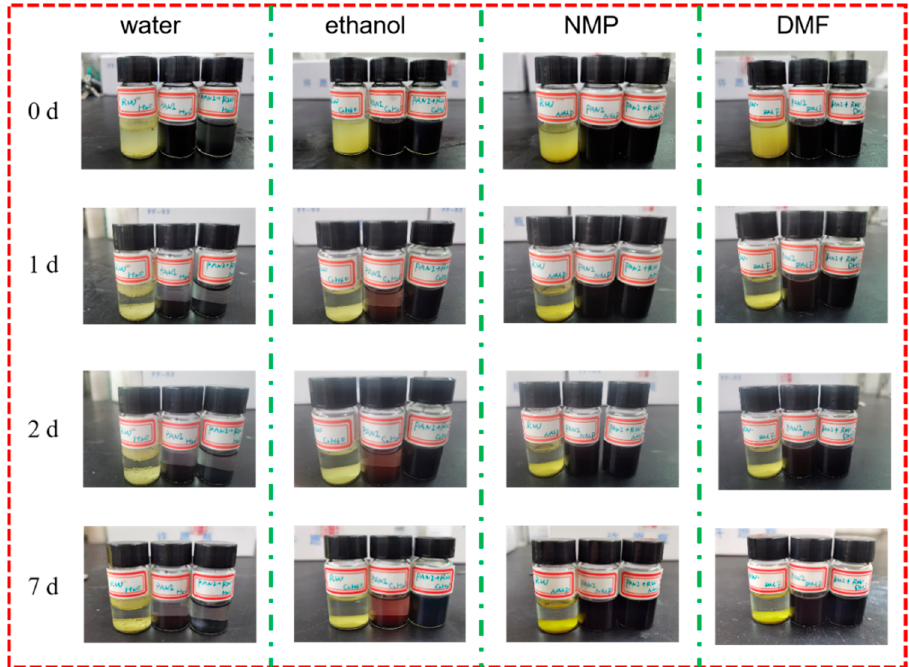
Figure 6. Dispersion stability of BRW, PANI, and PANI@BRW in different solvents (BRW, PANI, and PANI@BRW are arranged from left to right in each image).